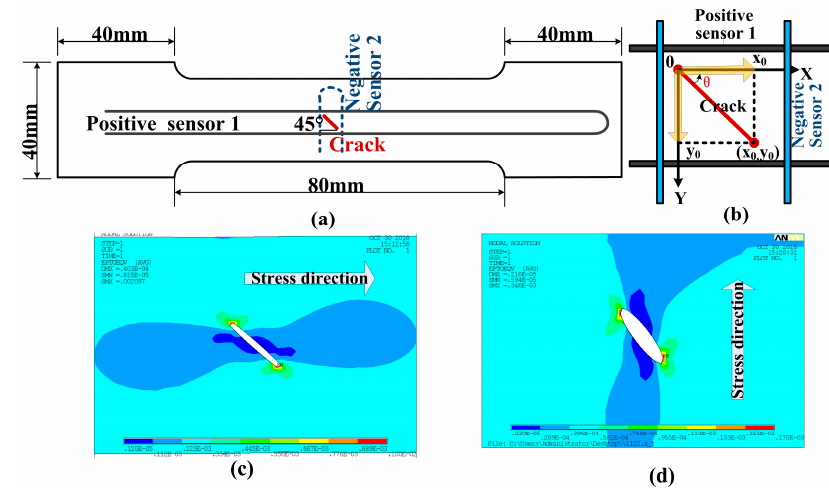
Figure 10. ( a ) Sensor placement in specimen3; ( b ) schematic diagram of the method for determining the crack angle; strain distributed simulation: ( c ) X -axis load; ( d ) Y -axis load.